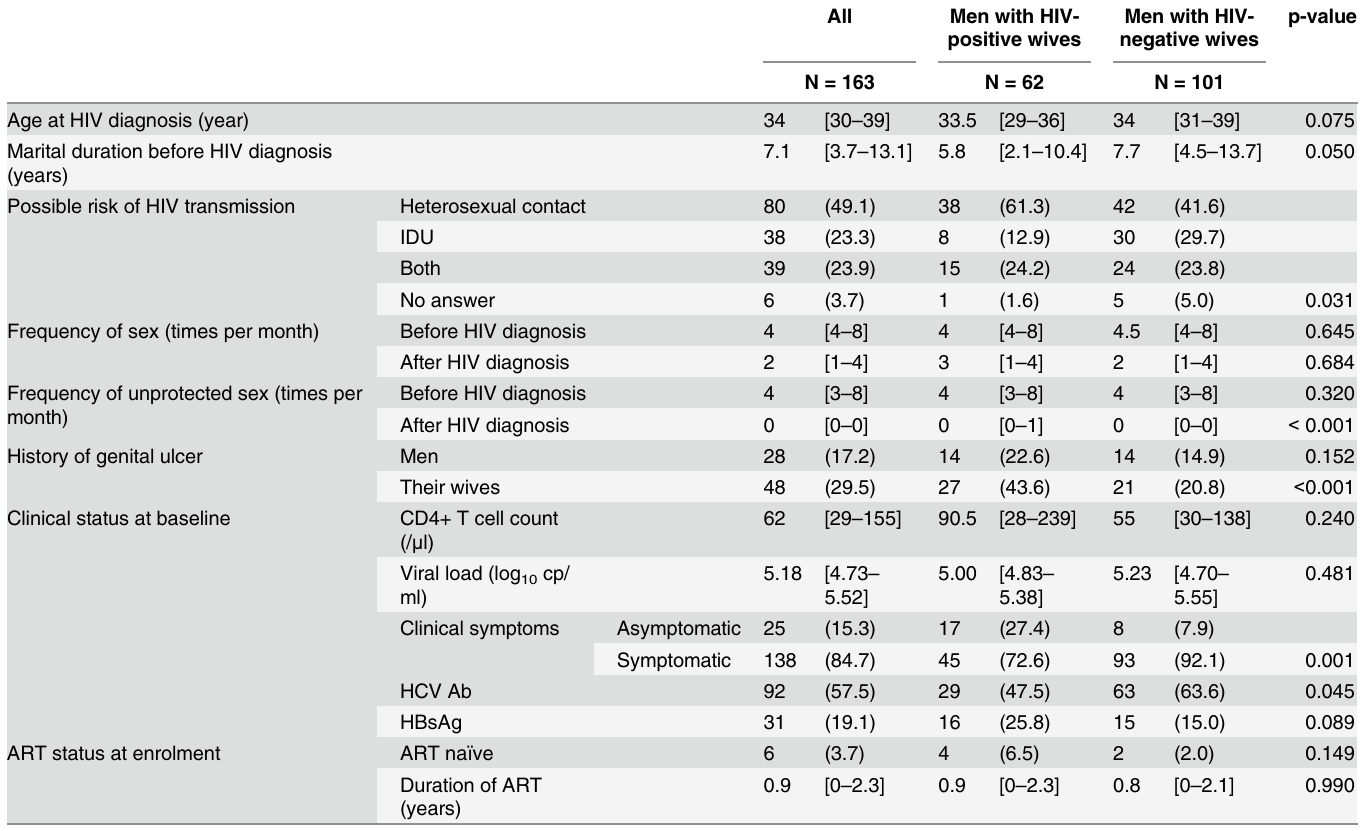
Table 1. Characteristics of HIV-positive married